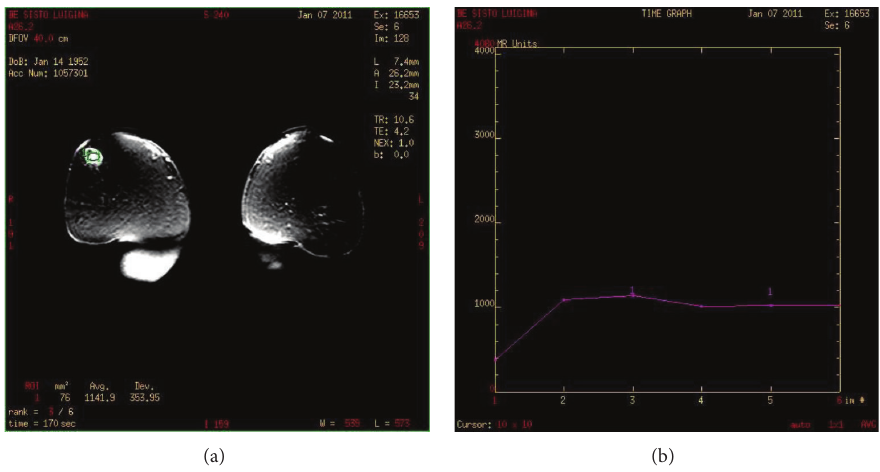
Figure 3: ROI on the lesion and curve 𝐼/𝑇 type 3 (malignant).